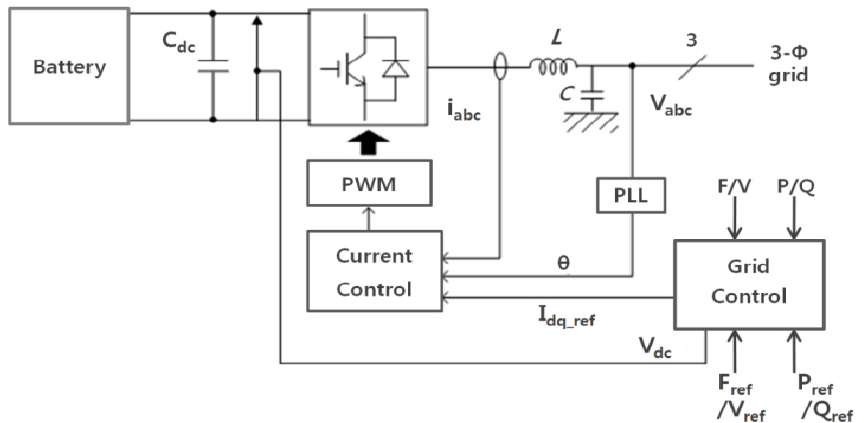
Figure 3. Configuration of